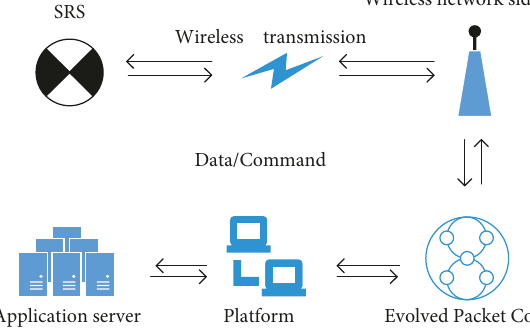
Figure 4: NB-IoT network